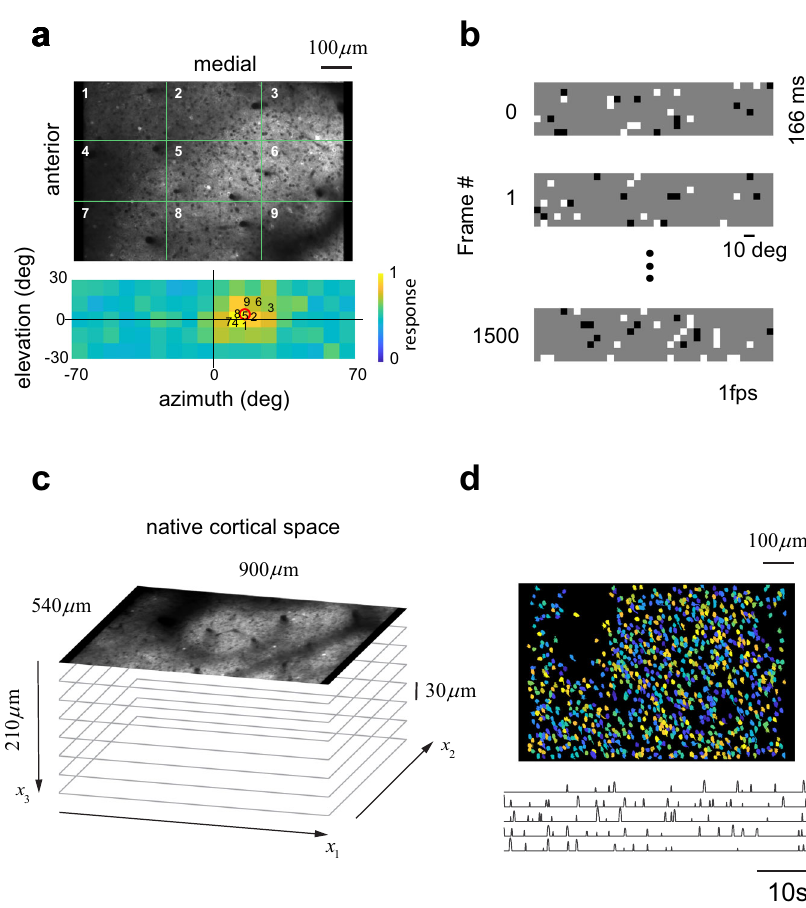
Fig. 1 Basic methods. a Coarse retinotopic mapping. The average signal originating from nine sectors de fi ned by a 3 × 3 grid on the fi eld of view of the microscope were used to map the aggregate receptive fi eld and determine its center. The image at the bottom shows the location of the centers for each sector superimposed on top of the aggregate receptive fi eld for the entire population (normalized to its peak). b Sparse-noise stimulus. Images were fl ashed for 166 ms and presented at a rate of 1 per second on a wide fi eld screen. c Volumetric sampling in primary visual cortex (see Methods for details on the volumes for each experiment). d Segmentation of regions of interest (ROIs) and fi ve sample traces showing spike inference from calcium signals. For visualization, ROIs are assigned random density of ON/OFF receptive fi eld centers on the visual fi eld conveyed by the geniculate input varies across the visual fi eld. If the retinotopic mapping between visual and cortical space is suf fi ciently accurate, such fl uctuations would be mirrored in the cortex, generating corresponding ON/OFF domains (Fig. 3a). According to such a biased-input model, ON/OFF domains simply mirror a property of the distribution of ON and OFF receptive fi elds centers on the visual fi eld. Therefore, such an arrangement predicts a correlation between the location of ON/OFF domains and the relative balance of ON/ OFF receptive fi eld centers represented by the geniculate population.